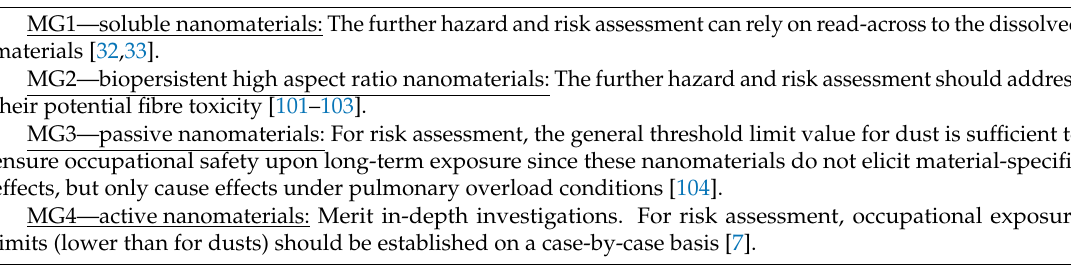
Figure S1: Sedimentation of colloidal amorphous SiO 2 in Krebs-Ringer phosphate glucose (KRPG) buffer determined by analytical ultracentrifugation. Yellow: 9 nm SiO 2 ; gray: 15 nm SiO 2 ; orange: 30 nm SiO 2 ; blue: 55 nm SiO 2 . Figure S2A: Fraction of deposited dose calculated with the DG model [1] applying the “sticky bottom” assumption. Yellow: 55 nm SiO 2 ; gray: 30 nm SiO 2 ; orange: 15 nm SiO 2 ; blue: 9 nm SiO 2 . Figure S2B: Fraction of deposited dose calculated with the DG model [1] applying the “reflective bottom” assumption. Yellow: 55 nm SiO 2 ; gray: 30 nm SiO 2 ; orange: 15 nm SiO 2 ; blue: 9 nm SiO 2 . Table S1: Analytical ultracentrifugation (AUC) measurements of the proportion of applied test materials that reached the bottom of the vials by sedimentation. Table S2: In vitro NR8383 rat alveolar macrophage assay: Cellular endpoint-specific test results obtained for 55 nm SiO 2 , 30 nm SiO 2 , 15 nm SiO 2 , and 9 nm SiO 2 (expressed as x-fold changes compared to corresponding medium